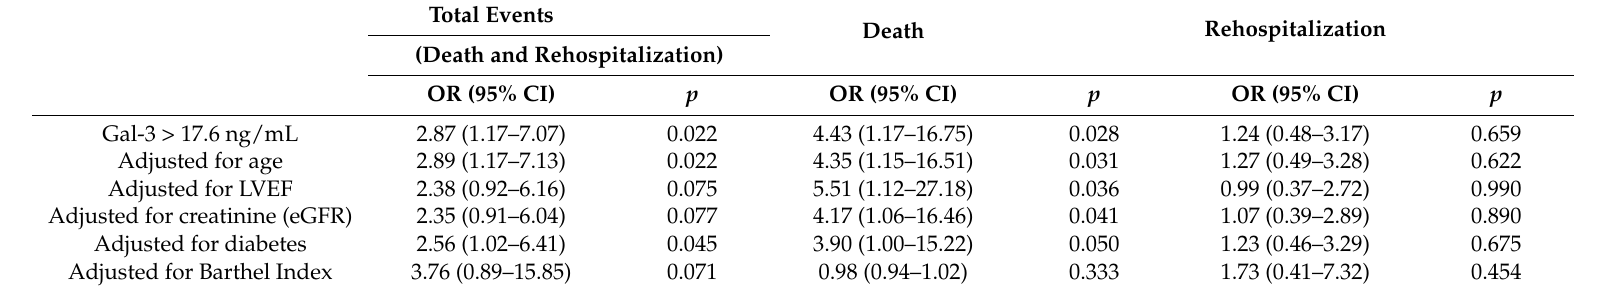
Table 3. Logistic regression: Galectin-3 value > 17.6 ng/mL.